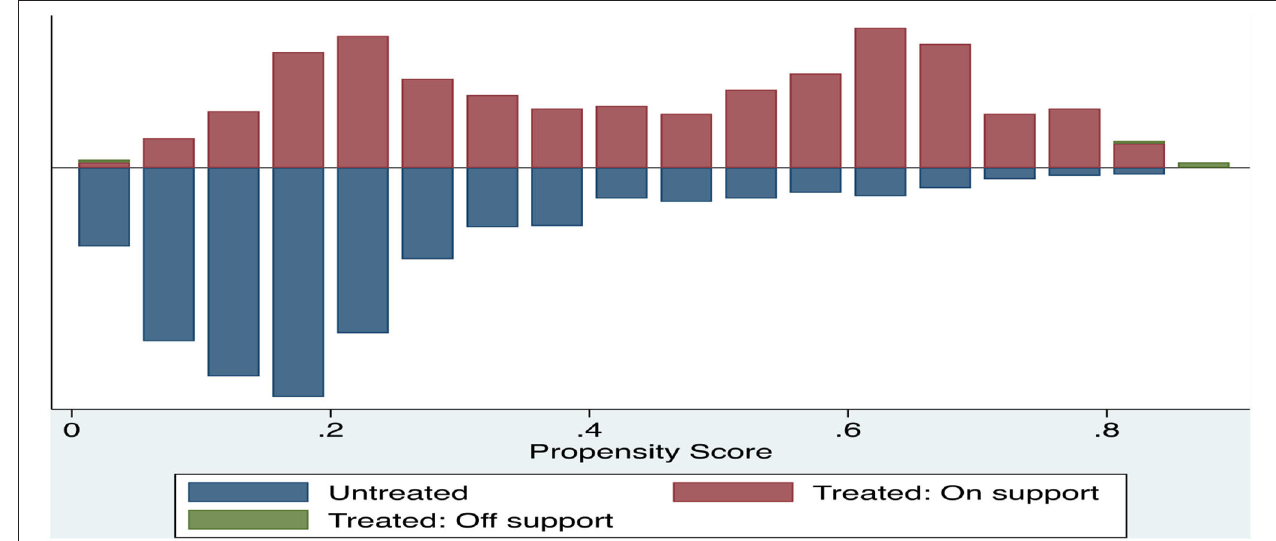
FIGURE 8 | Test of region of common support: per-capita asset value.